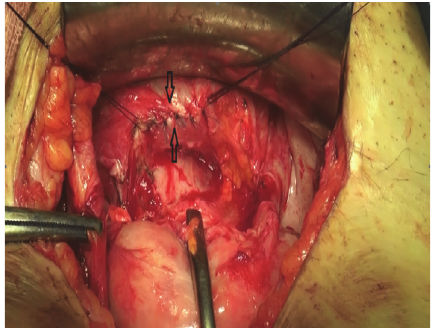
Figure 1: Fistula tract between the uterus anterior wall and bladder posterior wall in MRI.